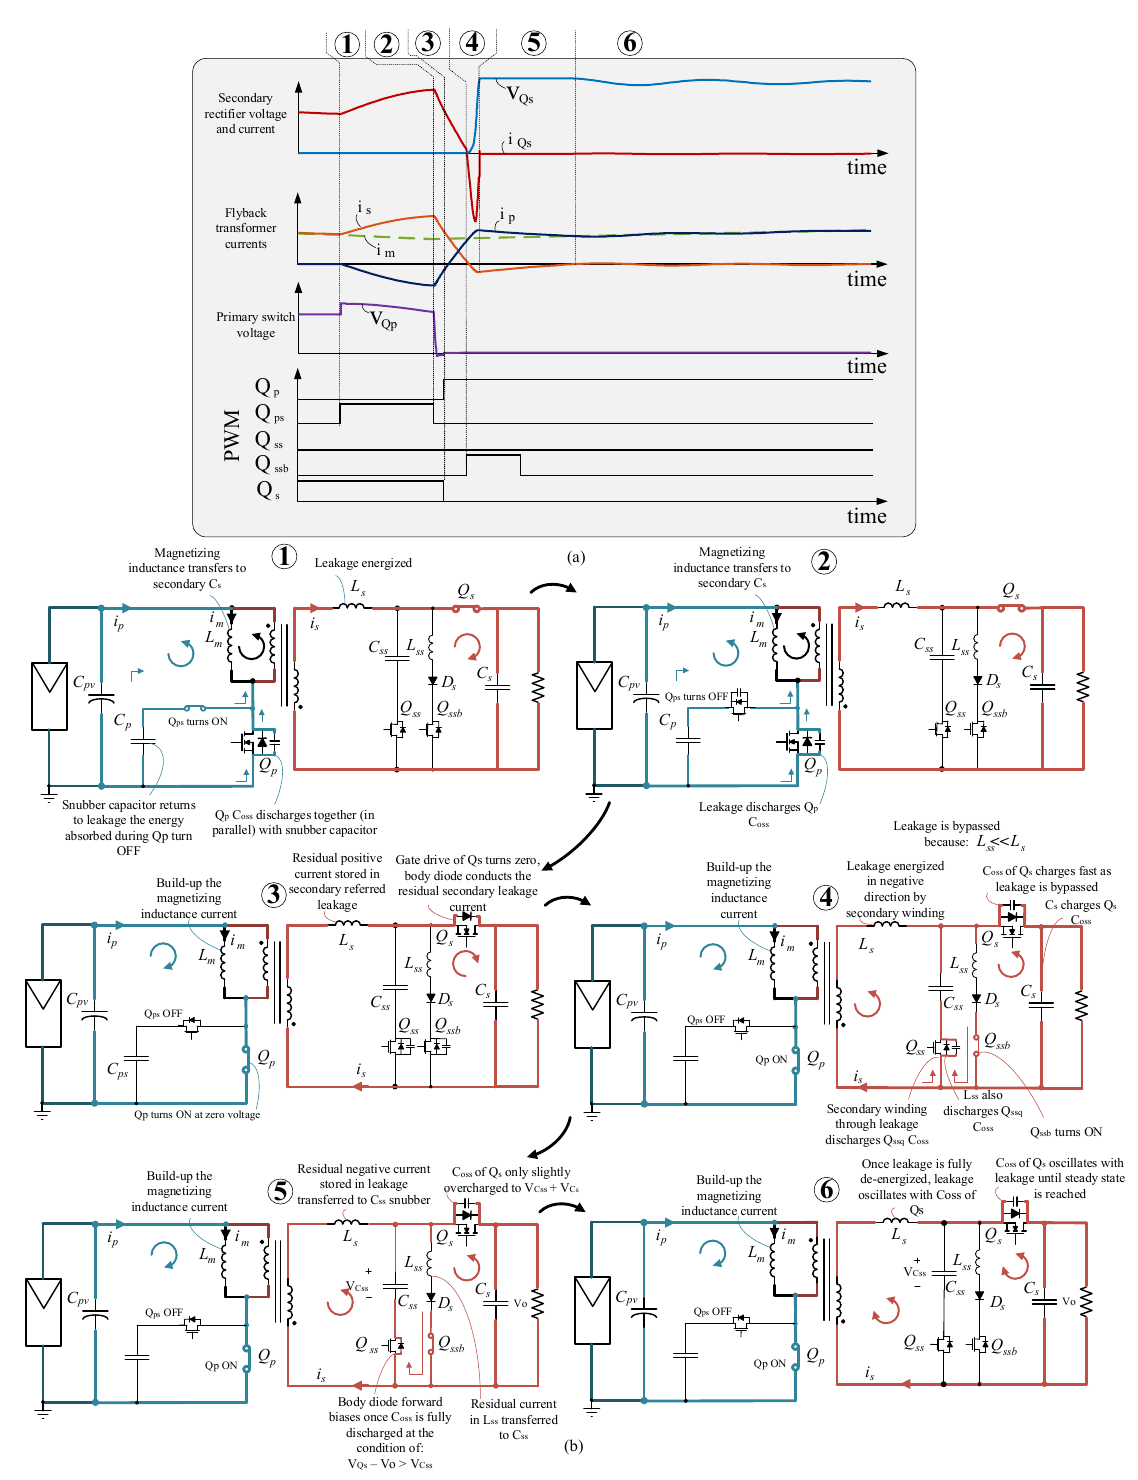
Figure 12. Sequences of states ( a ) waveforms of the states ( b ) circuit states.